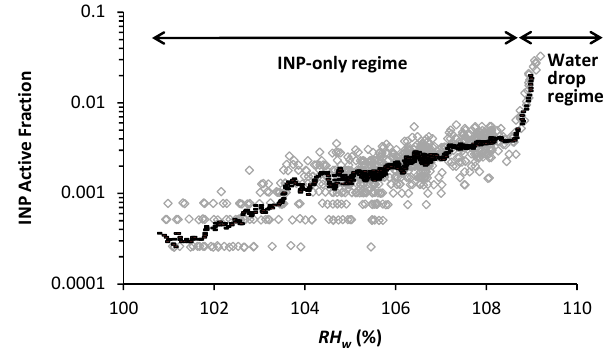
Figure 2. INP active fraction of mineral dust particles vs. RH w during a “scan” of RH w from low to high values during CFDC sampling from the AIDA chamber prior to a “first expansion” cloud formation experiment using a Saharan dust (type SD, AIDA experiment #20, 25 September 2007) aerosol distribution with n a = 411cm − 3 , d g = 0.18µm, and σ g = 2.14. A 15s running mean line overlays 1Hz data points. The regions of continuously increas- ing ice active fraction is distinguished from the region of onset of cloud droplet contamination of the ice signal above 108.5% RH w . Aerosol lamina temperature was maintained at 249.7K during the